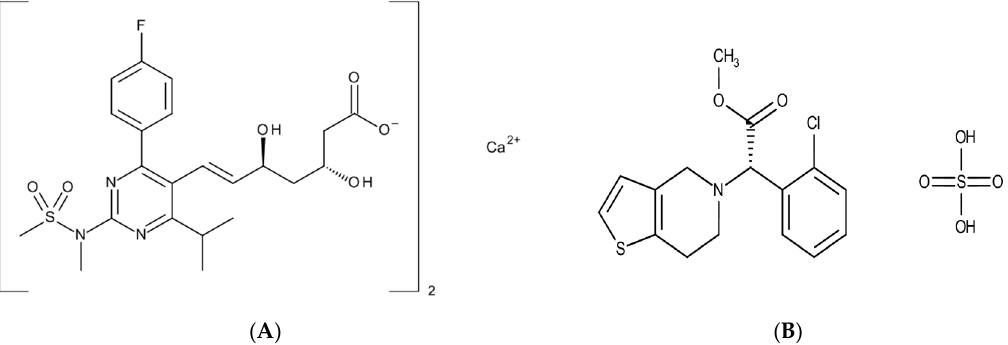
Figure 1. Chemical structures of rosuvastatin calcium ( A ) and clopidogrel bisulfate ( B ).